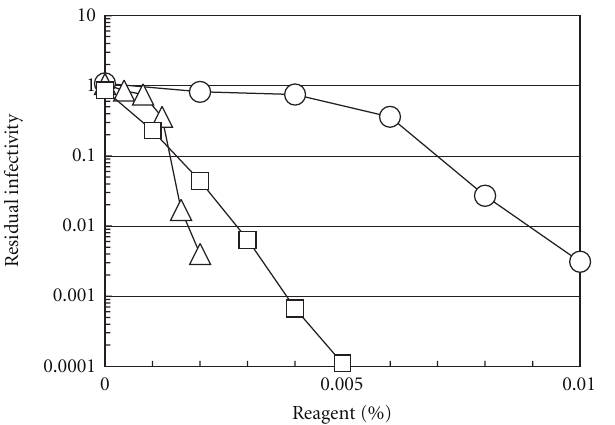
Figure 5: E ff ects of CAE, BKC, and SDS on the infectivity of HSV-2. HSV-2 was incubated in PBS (pH 7.4) containing varying concentrations of each compound at 30 ◦ C for 5 min. The amounts of infectious progeny viruses were determined by a plaque assay after the incubation and were normalized to that incubated in PBS (pH 7.4). Circles ( (cid:4) ) for CAE; triangles ( (cid:5) ) for BKC; squares ( (cid:2) ) for SDS.